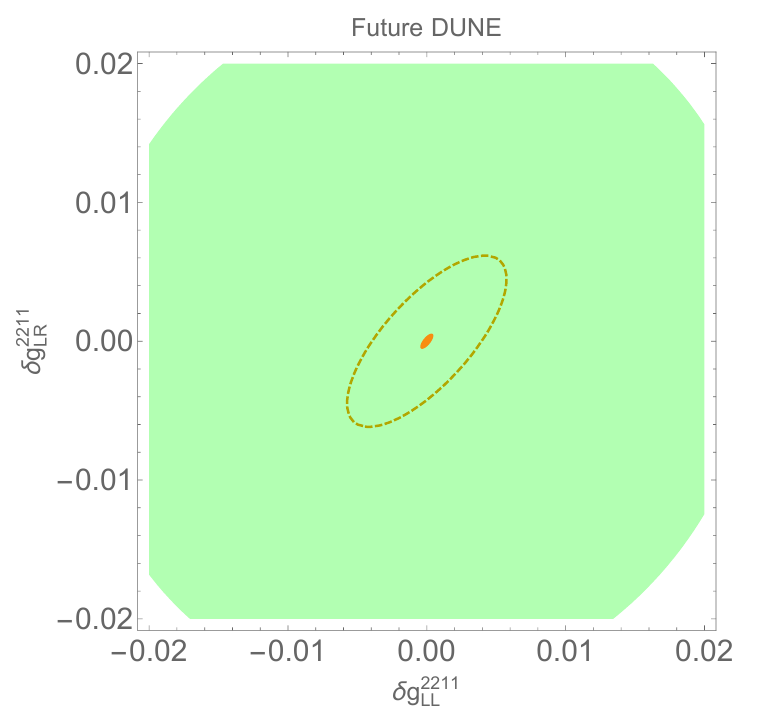
and g 2211 in LL LR